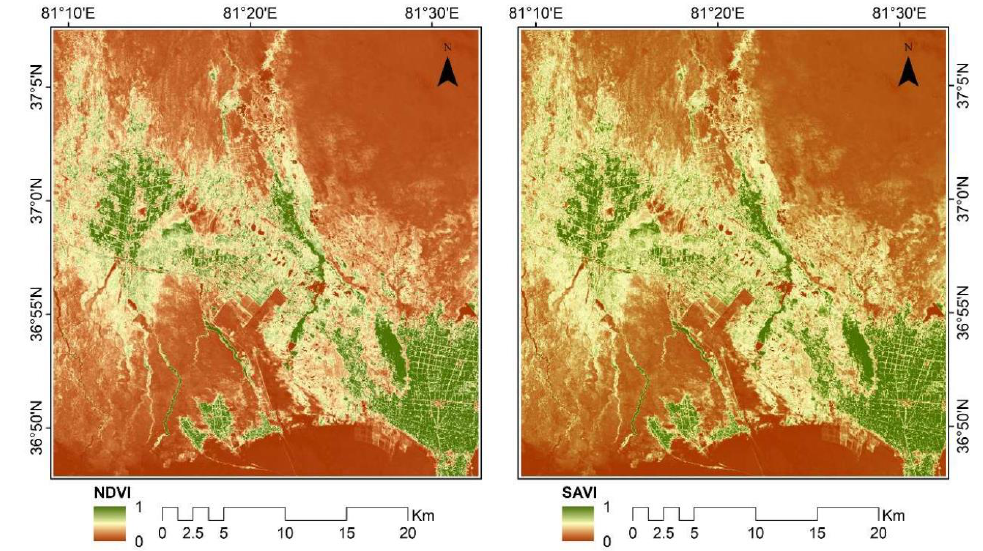
Figure 5. Vegetation index extraction results.